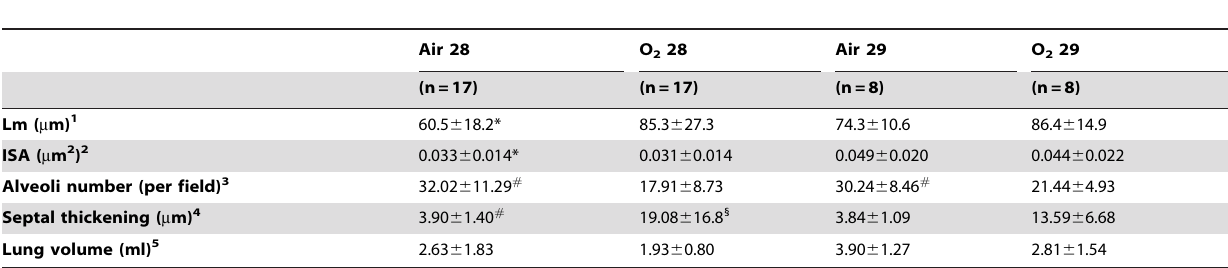
Table 1. The values of Lm and ISA and the number of alveoli and septal thickening are shown in the